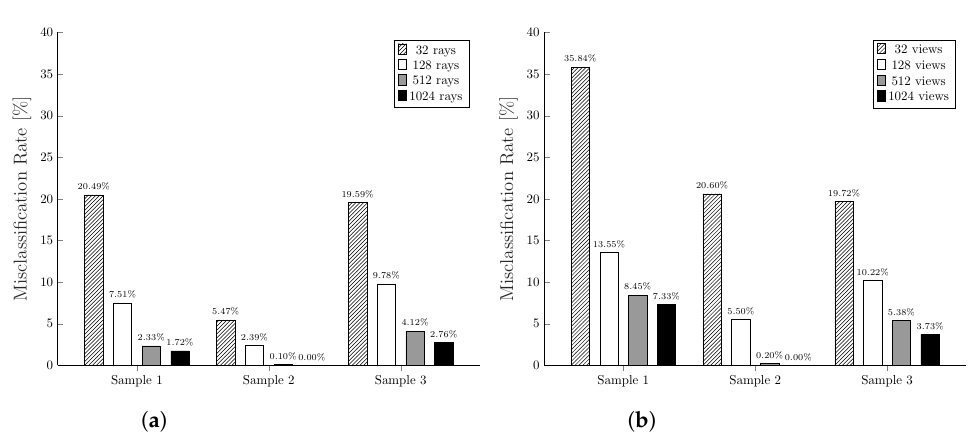
Figure 17. Misclassification rates comparison of the two algorithms using different settings and sam- ples. ( a ) shows the results obtained with Plücker VSD, ( b ) shows the results obtained with Mesh- Lab VSD.